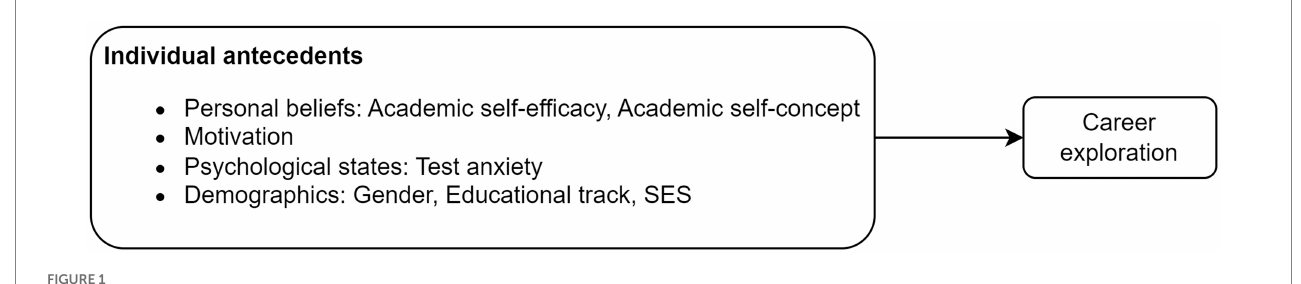
FIGURE 1 The conceptual model for this